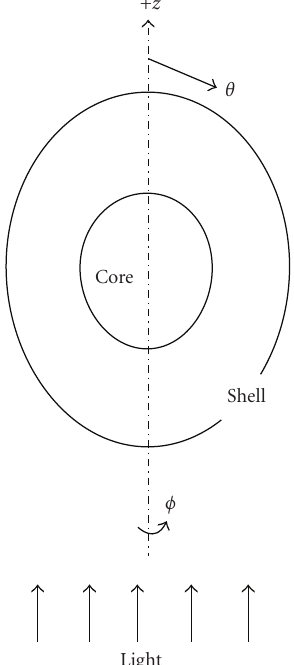
Figure 1: Schematic diagram of a microsphere. The monochro- matic unpolarized light irradiates a core-shell microsphere in the + z direction.